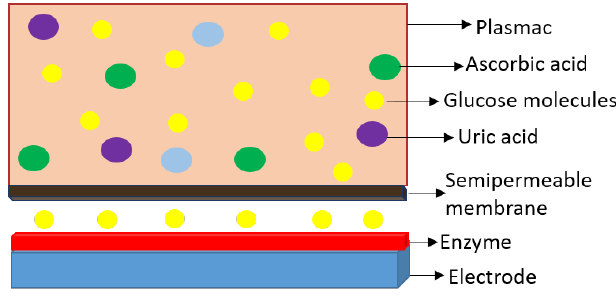
Figure 4. Basic working principle of semipermeable membrane. Table 1. The chemical structures of commonly used semipermeable membranes in biosensing.